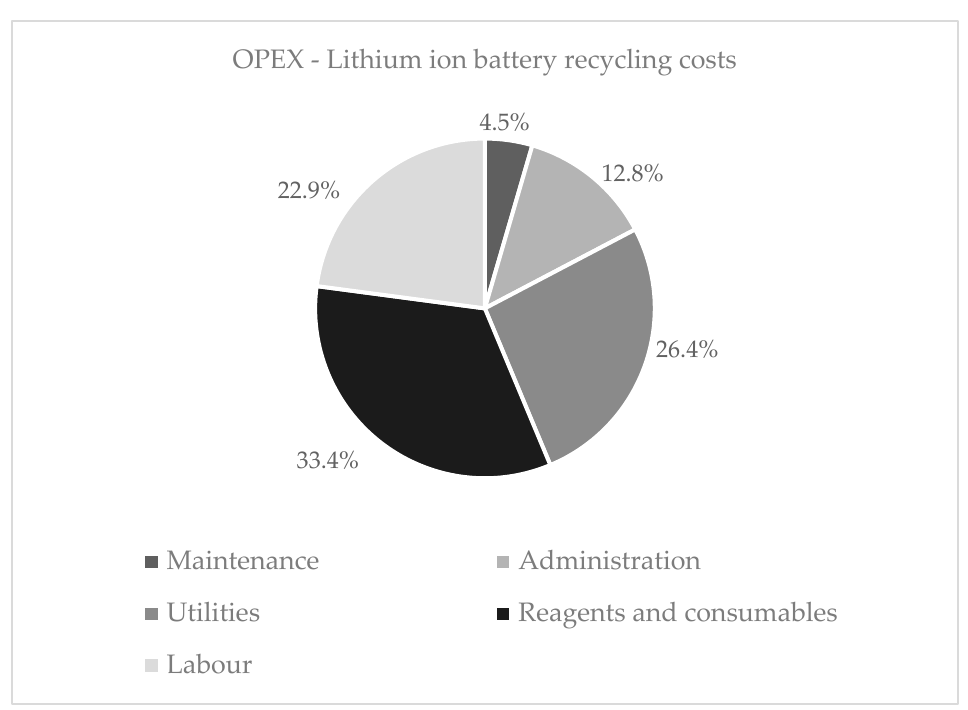
Table 10. OPEX values estimated for the company Li-Cycle. Source: [38].